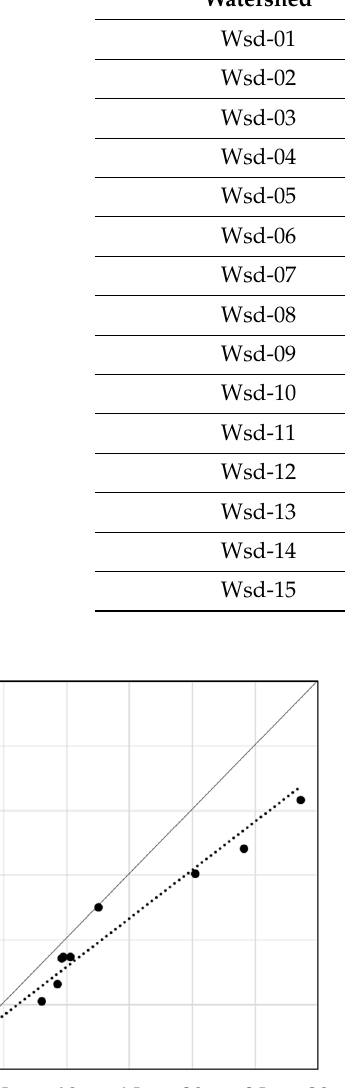
Table 5. NSE and R 2 of measured and estimated monthly streamflows during validation.